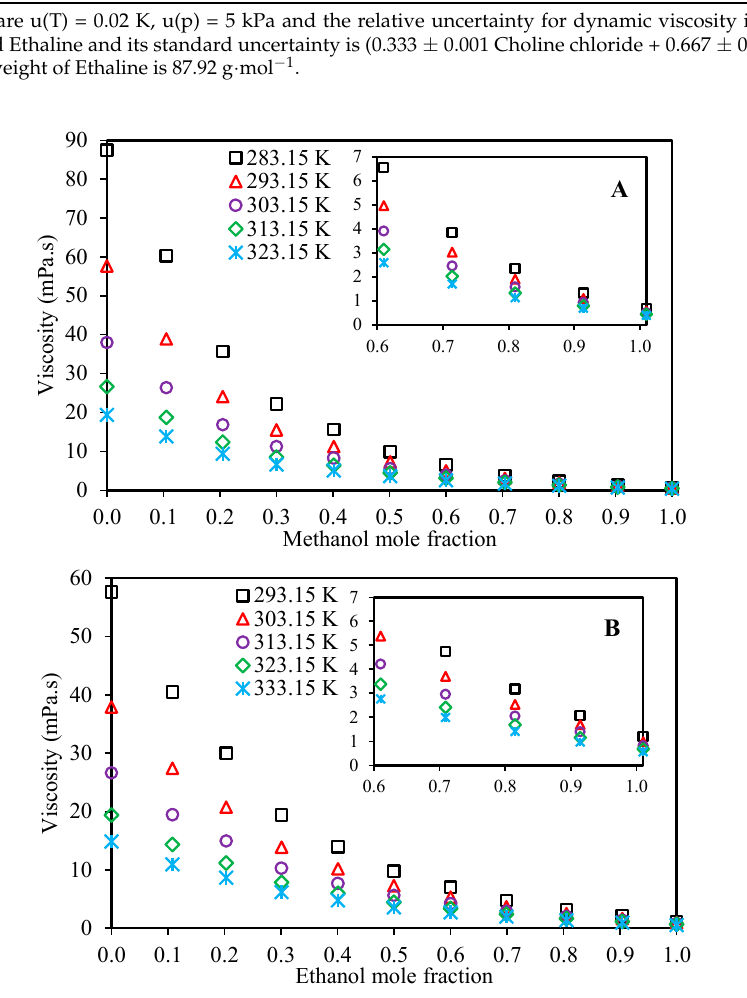
Figure 2. Viscosity behavior of the mixtures with respect to alcohol concentration for the investigated systems at a pressure of 100 kPa ( A : Ethaline (1 ChCl:2 ethylene glycol) + methanol, B : Ethaline (1 ChCl:2 ethylene glycol) + ethanol).